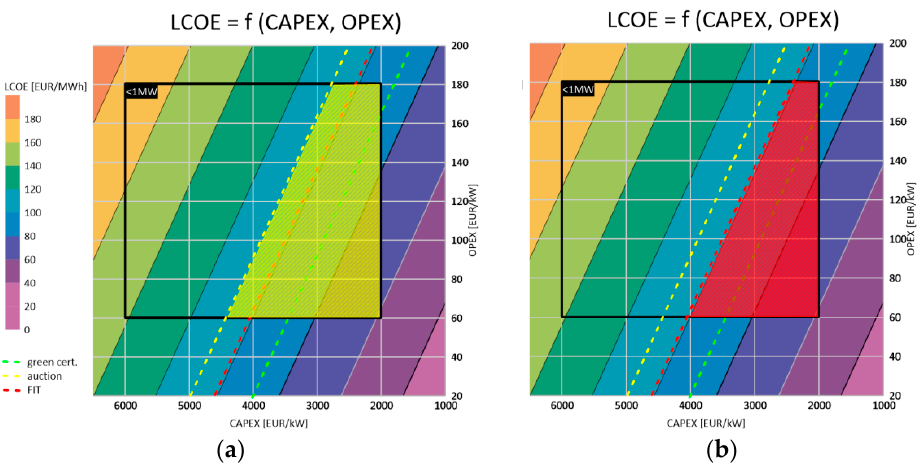
Figure 7. Examples of CAPEX and OPEX boundaries for SHP ensuring obtaining LCOE at the level of revenues that can be obtained ( a ) in the auction system, ( b ) in the FIT system. Source: own elab ‐ oration.